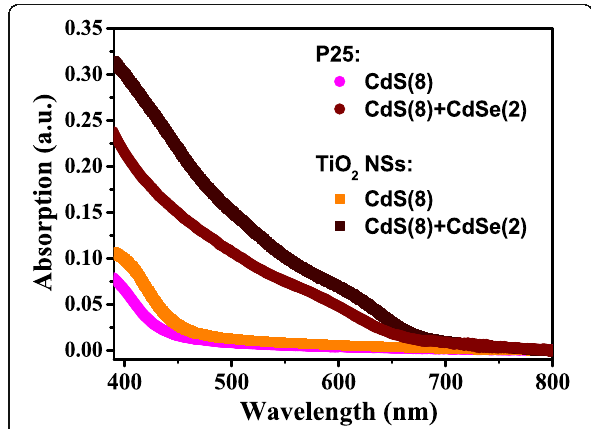
Fig. 4 UV-VIS absorption spectra of ~ 3- μ m-thick TiO 2 NSs and P-25 sensitized by CdS and CdSe QDs. The number in parenthesis indicates the coating cycles of the SILAR (for CdS) and CBD (for CdSe) processes